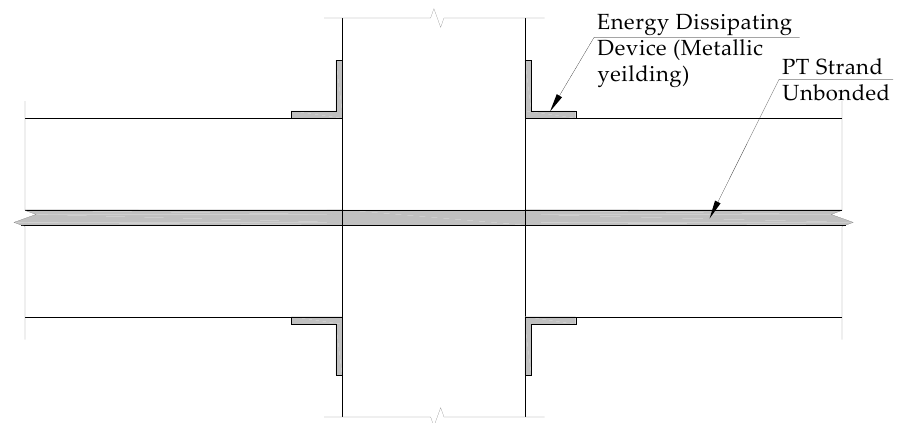
Figure 28. The proposed precast post-tensioned beam column connection (undeformed) [54].